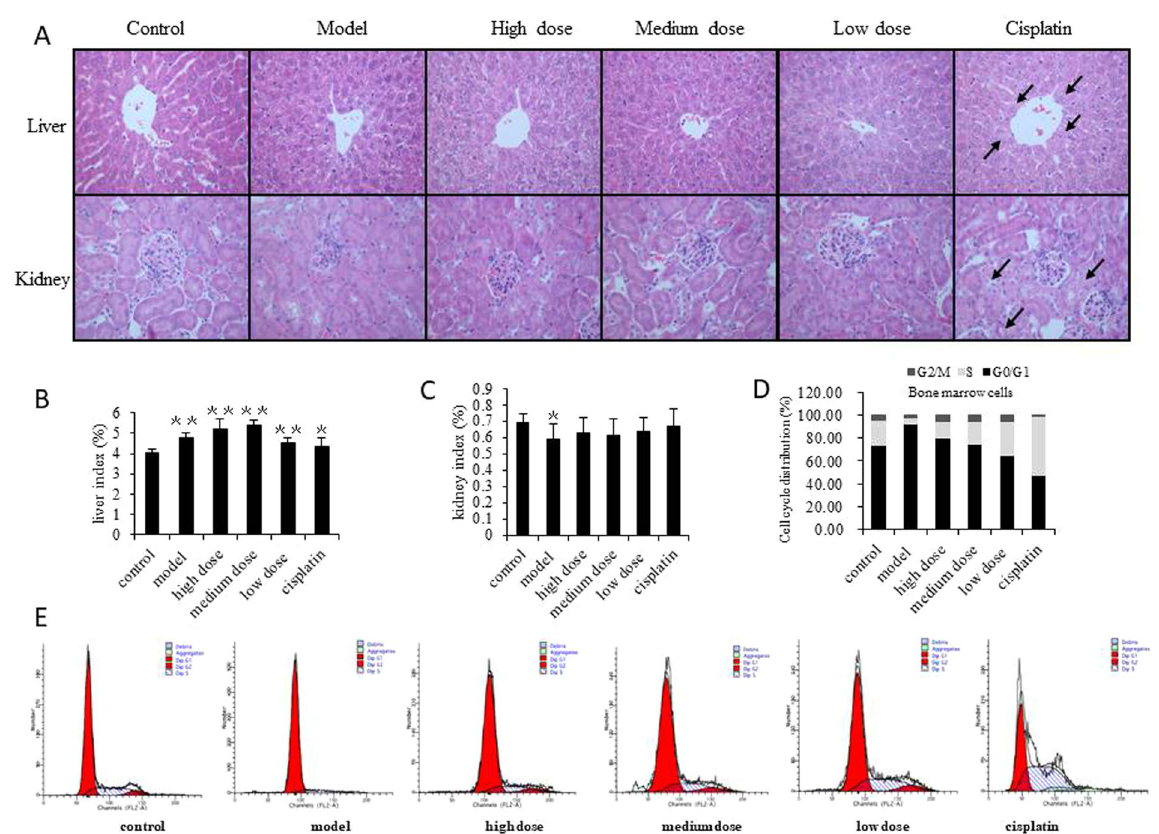
Figure 2. The toxicological impact of GLE treated tumor-bearing mice. ( A ) Pathological examination was used to detect toxic damage of liver and renal tissue in all groups. Sections of liver and renal tissue in mice were stained using HE followed by observation on a phase-contrast microscope ( × 400). Obvious changes are highlighted by arrows. The structure of the hepatic lobule was intact, and no inflammatory cell infiltration was found in the portal area and the liver proper. Six hours prior to sacrifice, mice had not been fasted, thus each group showed vacuoles in the liver cells. This simply indicated glycogen accumulation in the liver cells was not associated with pathology. Likewise, hypertrophy of hepatocytes around the central vein of the liver tissue in cisplatin group was attributed to damage to liver cells caused by cisplatin. ( B , C ) Effects of GLE on liver and renal indexes were analyzed in tumor-bearing mice. ( D , E ) GLE improves the suppression of bone marrow cells in tumor-bearing mice. FACS was used to detect the effects of GLE on the cell cycle progression of bone marrow. Representative results of three independent experiments are shown. Error bars, SD; * P < 0.05; ** P < 0.01, versus control values; Δ P < 0.05; ΔΔ P < 0.01, versus model values.